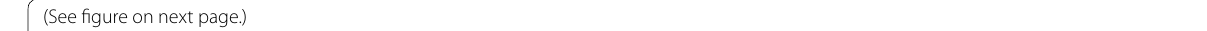
Fig. 4 Effects of DLP-1 and DLP-2 on mRNA and protein expression of TLR-4, MyD88 and TRAF-6. Cells were treated with LPS (1 μg/mL) for 24 h in the presence or absence of A DLP-1 (5 μg/mL) and B DLP-2 (50 μg/mL), respectively. The mRNA expression levels were determined by qRT-PCR. The protein expression was detected by western blotting assay. β-Actin was used as loading control. Values were mean letter were not significantly different at P < 0.05, in accordance with Duncan’s multiple